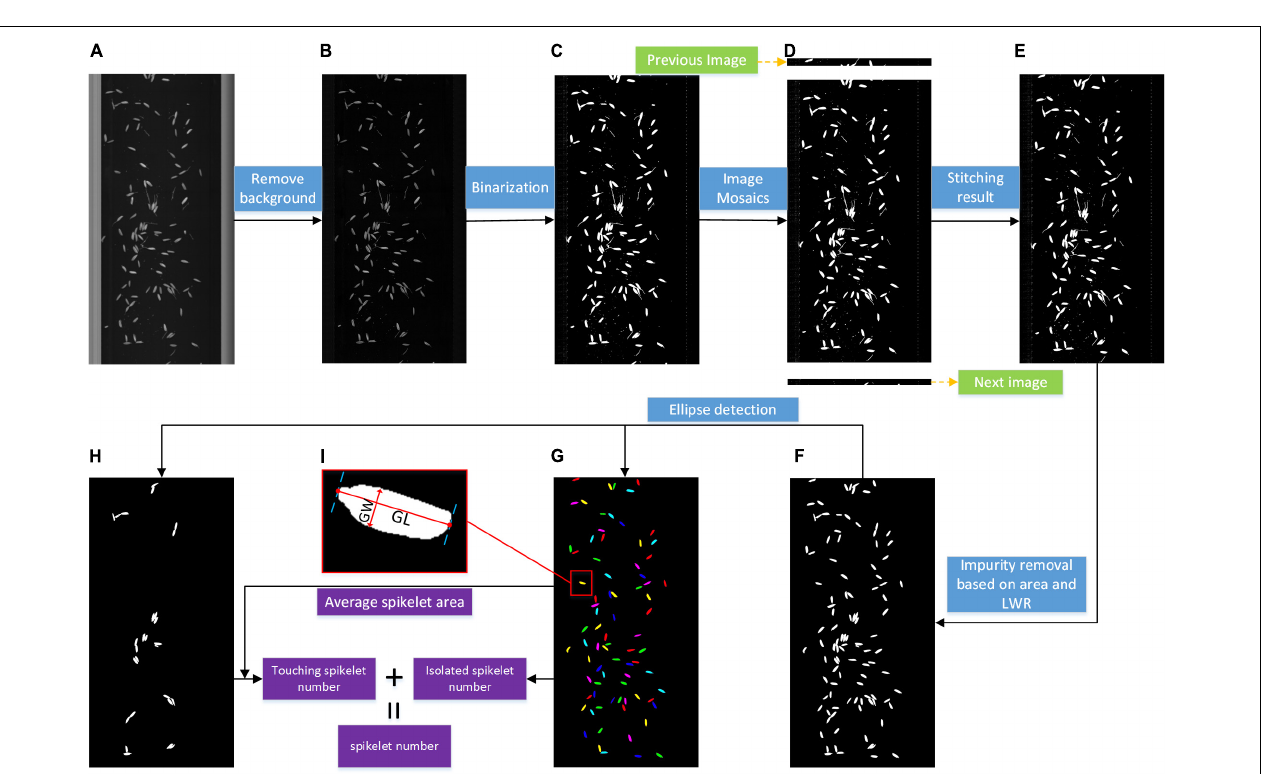
FIGURE 3 | Software workflow in the system: (A) system control, (B) image acquisition, (C) image analysis, (D) cloud communication, and (E) result exhibition.